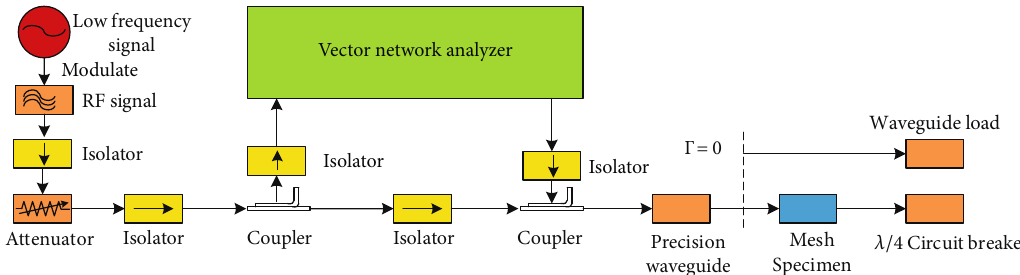
Figure 4: Electrical property test scheme by waveguide method.